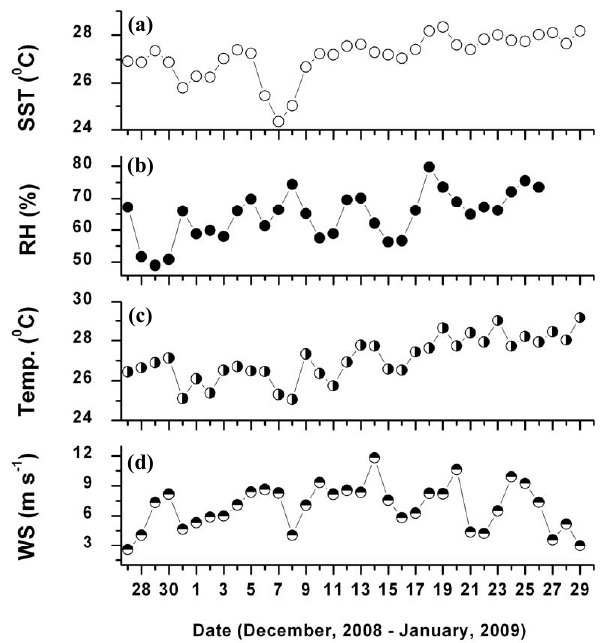
Fig. 3. Day-to-day variation of (a) sea surface temperature (SST), (b) relative humidity (RH), (c) air temperature and, (d) wind speed (WS) over BoB during